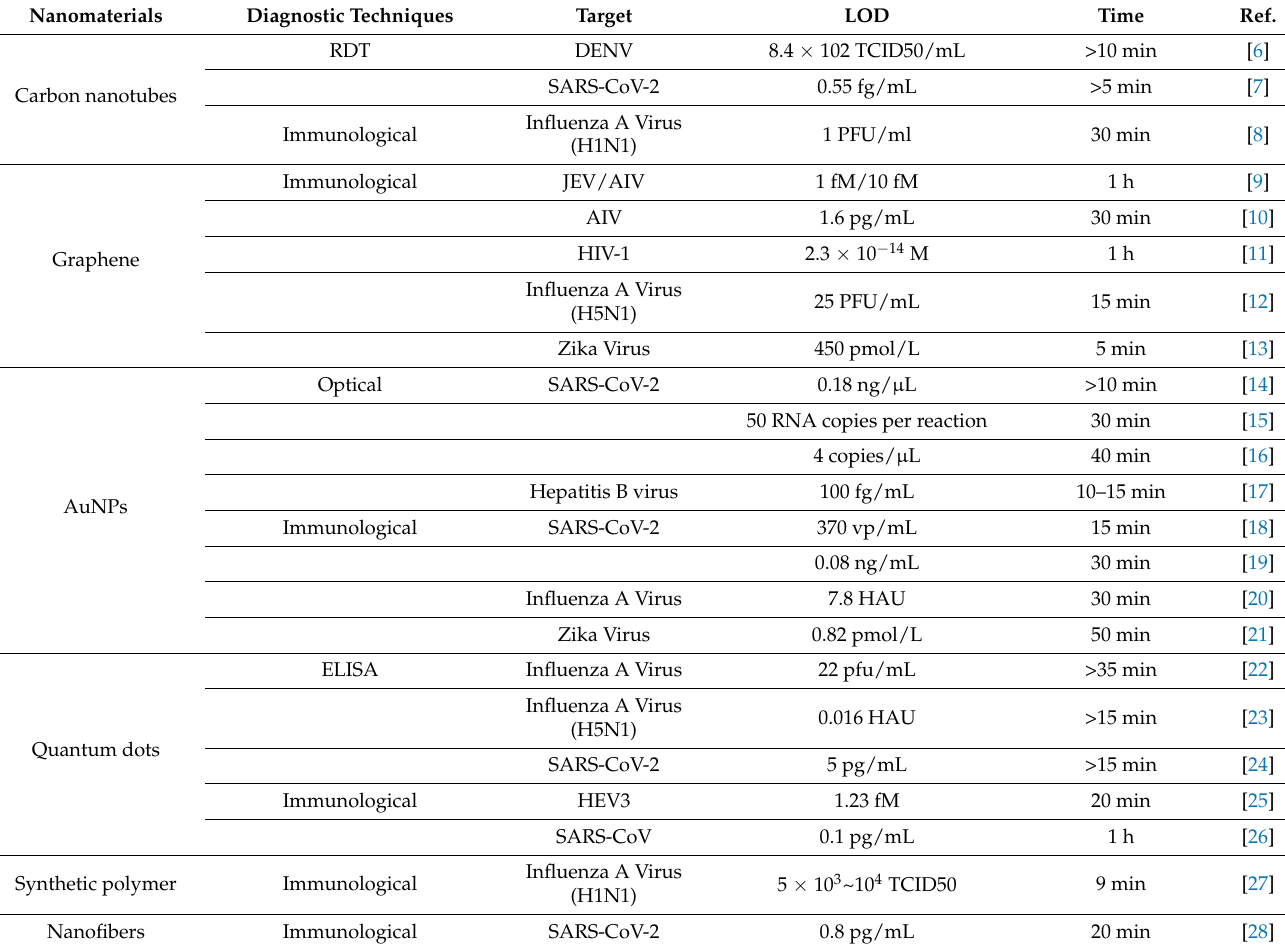
Table 1. Nanomaterial-based diagnostics for emerging and re-emerging viral diseases.